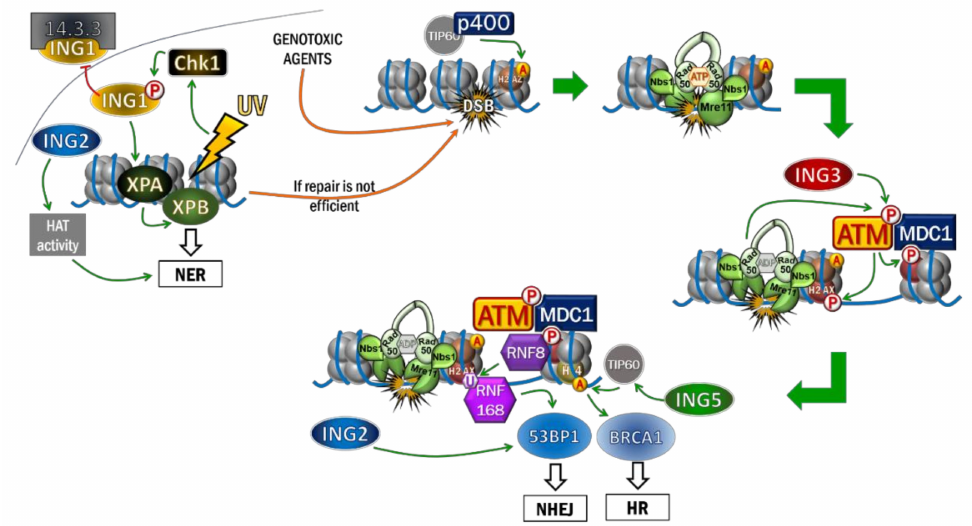
Figure 4. ING proteins are involved in the DNA Damage Response. ING1 is involved in UV damage: activated after UV damage, Chk1 phosphorylates ING1 on Ser126 which will stabilize it. ING1 is then able to promote XPA recruitment and subsequent DNA repair by NER. ING2, which facilitates NER, is also required in DSB repair in which it participates in 53BP1 accumulation at DSB sites. ING3 participates in the DDR pathway by promoting ATM activation and the signaling pathway that finally leads to the accumulation of 53BP1 or BRCA1 then initiating repair by either NHEJ or HR respectively. ING5 was described as a TIP60 cofactor that promotes BRCA1 accumulation thanks to H4K16